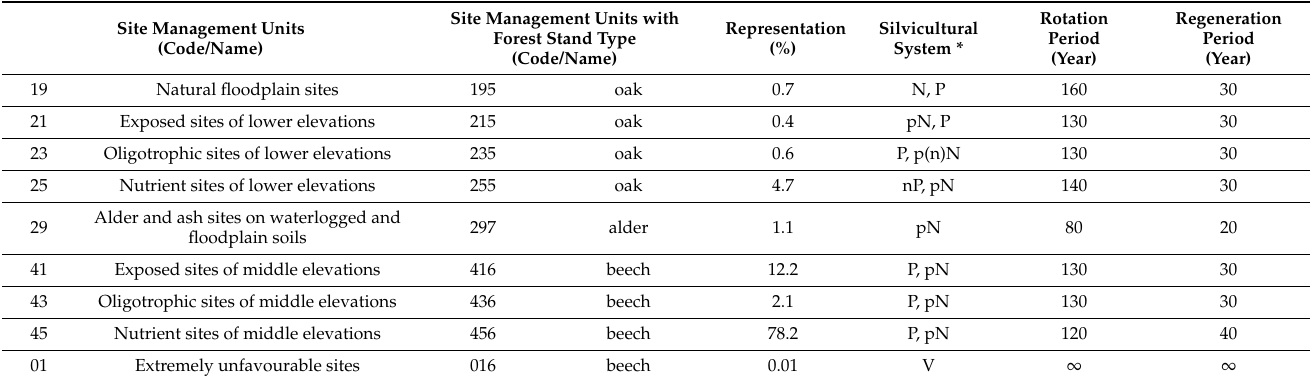
Table 3. Overview of management files for forest stands in the catchment area of watercourses with C. heros in Chˇriby hills.